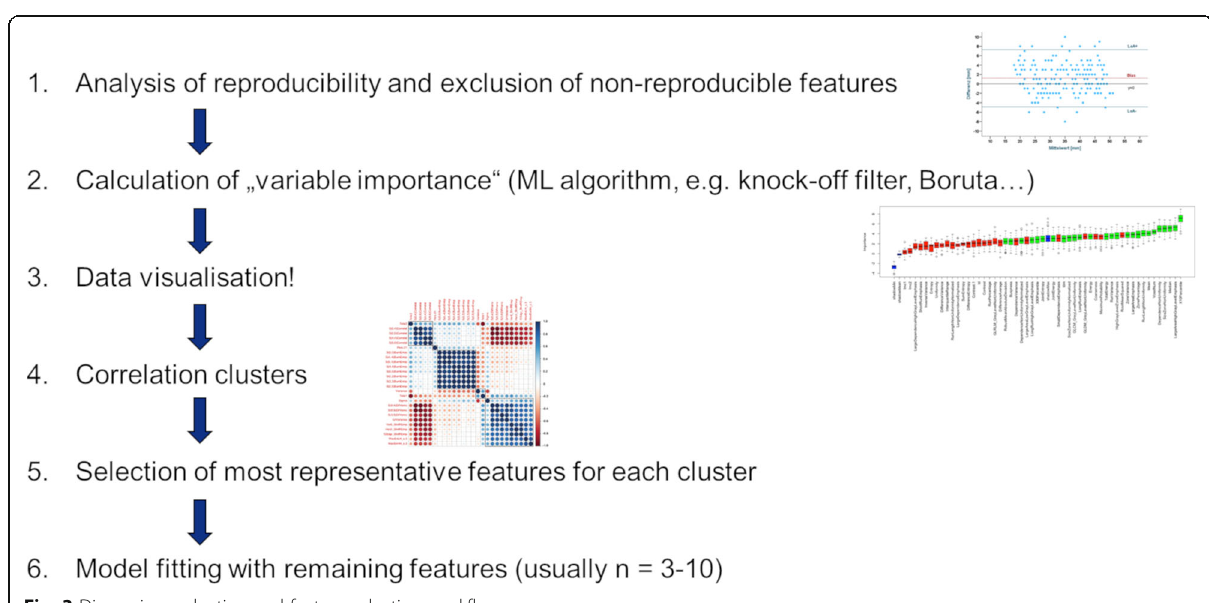
Fig. 3 Dimension reduction and feature selection